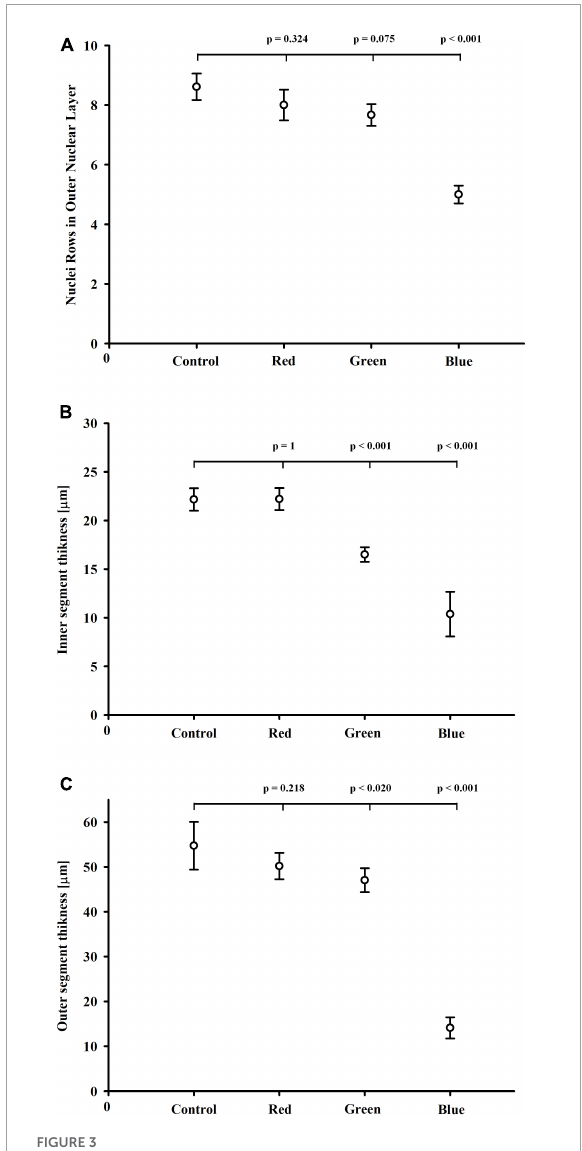
FIGURE3 Effect of monochromatic light exposure on the outer nuclear layer and photoreceptor segment thickness. The rats were exposed to 12 h white light (150 lx) and 12 h darkness for 7 days (control, 32 rats), 12 h red light (150 lx) and 12 h darkness for 7 days (red-light group, 32 rats), 12 h green light (150 lx) and 12 h darkness for 7 days (green-light group, 32 rats) and 12 h blue light (150 lx) and 12 h darkness for 7 days (blue-light group, 32 rats). Retinal samples were collected at 11:00 ( n = 4) and 14:00 ( n = 2). P -values and 95% confidence intervals were calculated with Dunnett’s test. (A) Nuclei rows in the outer nuclear layer in retinas from control, red-, green-, and blue-light exposure groups. Photoreceptor inner (B) and outer (C) segment thickness in the control, red-, green-, and blue-light exposure groups.